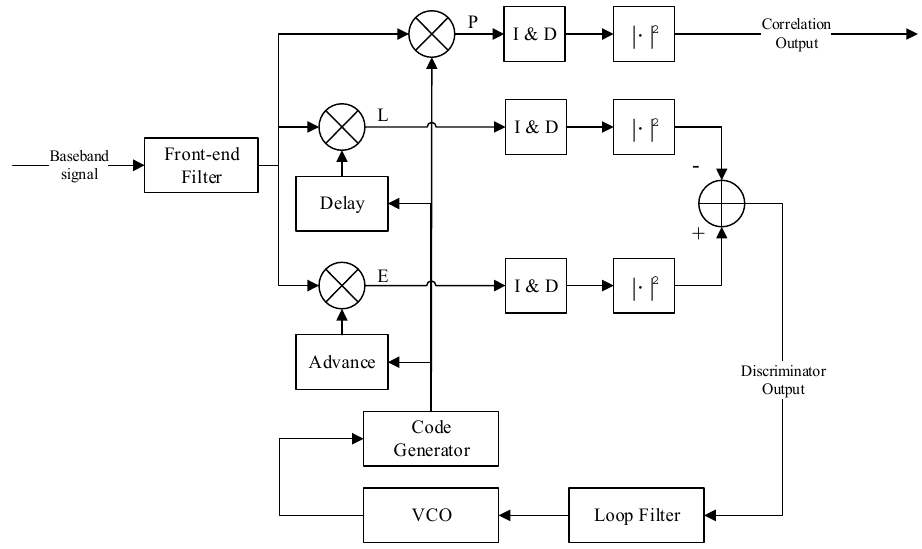
Figure 1. Block Diagram of Non-coherent Code Tracking Loop, where the discriminator model is early minus late power.